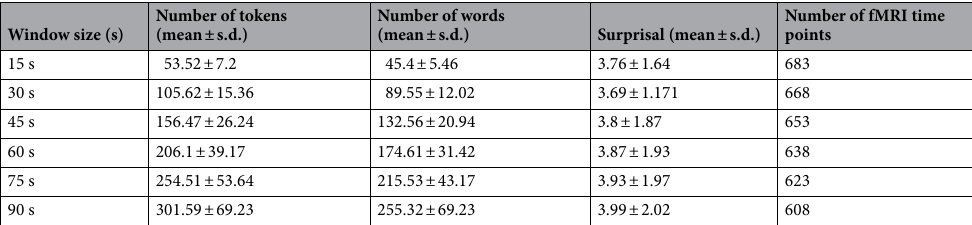
Table 1. Descriptive values of each input window. A set of context tokens (i.e., all the previous tokens contained in the time window) were assigned to each available token (n = 2512) and provided in input to the GPT-2 model to estimate both the surprisal value and the associated saliency scores. The size of theses input contexts varied across time windows and tokens. Therefore, for each time window, the sizes of all the input contexts, expressed both in number of tokens and number of (meaningful) words, were averaged across all the available tokens and reported in the second and third column of the table. Raw surprisal values estimated for each token, were first convolved with the hemodynamic response, and then down sampled to the number of available fMRI time point (i.e., 709). The average surprisal value across the fMRI time points are reported in the fourth column of the table. The use of a sliding window approach and the variable size of the time windows allowed the use of a reduced subset (i.e., lower than 709) of fMRI time points for the saliency score analysis. In the fifth column of the table the number of fMRI time points available for the saliency score analysis is reported for each time window.